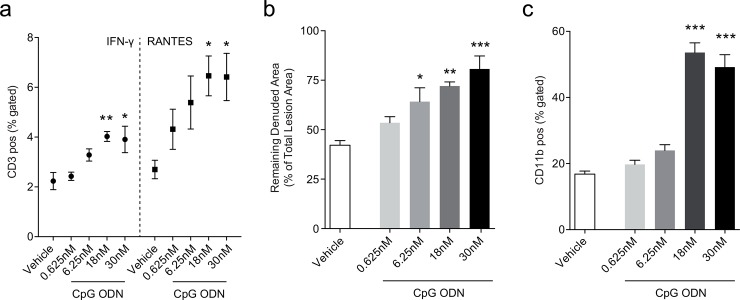
Proinflammatory response by concentration dependent TLR9 activation in acute vascular injury.WT mice were subjected to an electric denudation of the left carotid artery as described in Fig 1 and received repetitive s.c. injections of 0.625nM (n = 7), 6.25nM (n = 7), 18nM (n = 6), 30nM CpG ODN (n = 7) or vehicle (n = 7) over 7 days. Splenic CD3 positive lymphocytes from 18nM and 30nM CpG ODN treated mice expressed more IFN-γ and RANTES compared to vehicle controls (a). TLR9 activation by 6.25nM, 18nM and 30nM CpG ODN significantly impaired reendothelialization in WT mice compared to vehicle controls (b). Further, stimulation with 18nM and 30nM CpG ODN elevated levels of circulating CD11b positive cells (c). Data are presented as mean±SEM. Statistical analysis was performed using ANOVA (Holm-Sidak's multiple comparisons test). *p<0.05, **p<0.001, p***<0.0001.